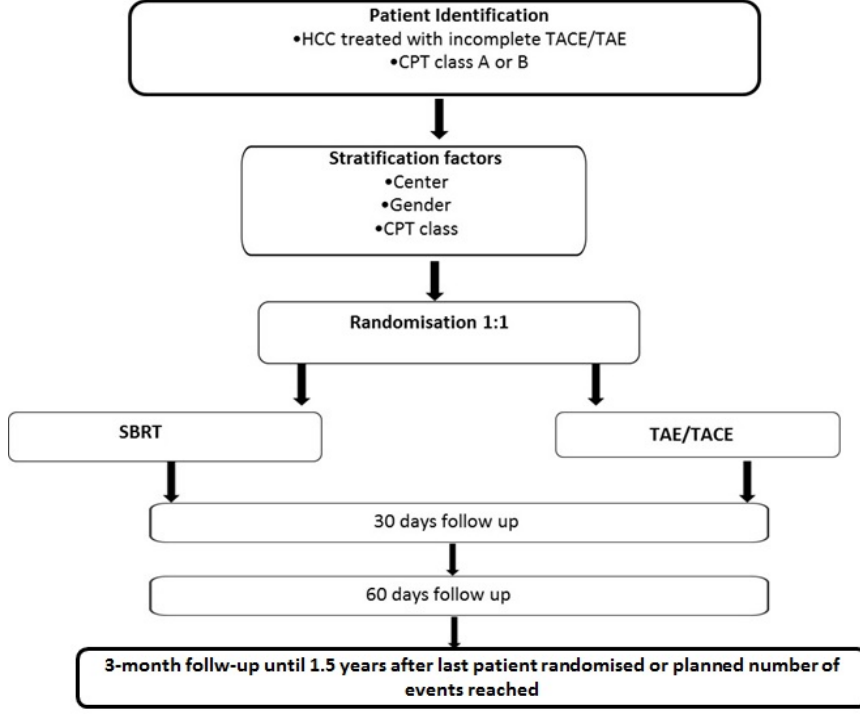
Figure 1. Study Plan. CPT: Child – Pugh – Turcotte. SBRT: Stereotactic Body Radiotherapy. TAE/TACE: Transarterial Embolization/Transarterial Chemo-Embolization.